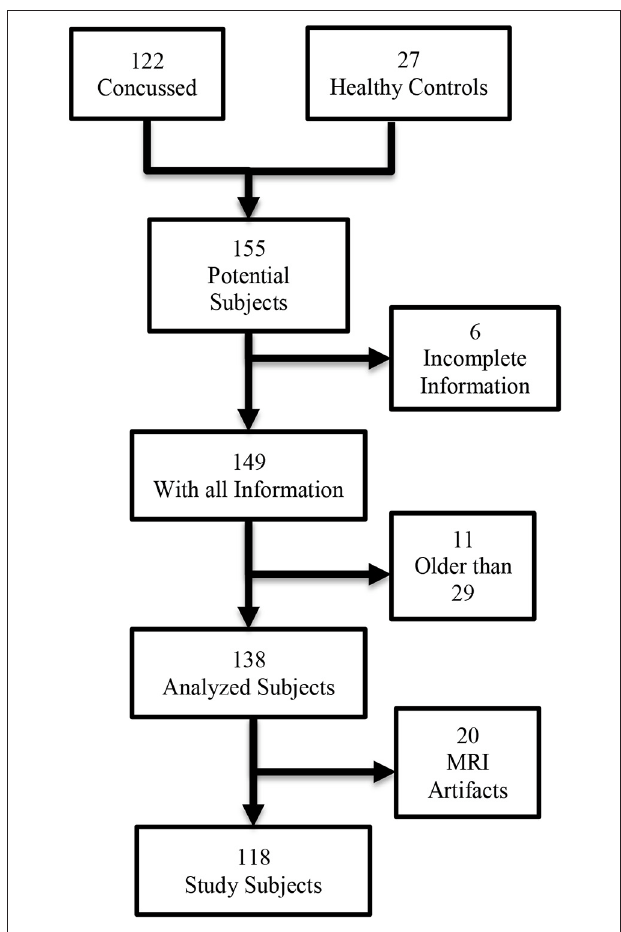
FIGURE 1 | Inclusion criteria for post-concussive syndrome radiomics association study.